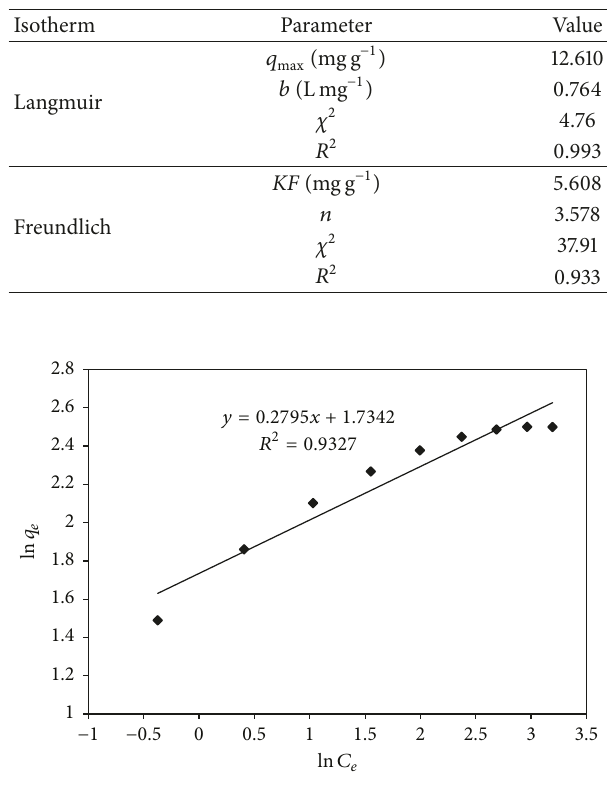
Figure 10: Freundlich isotherm